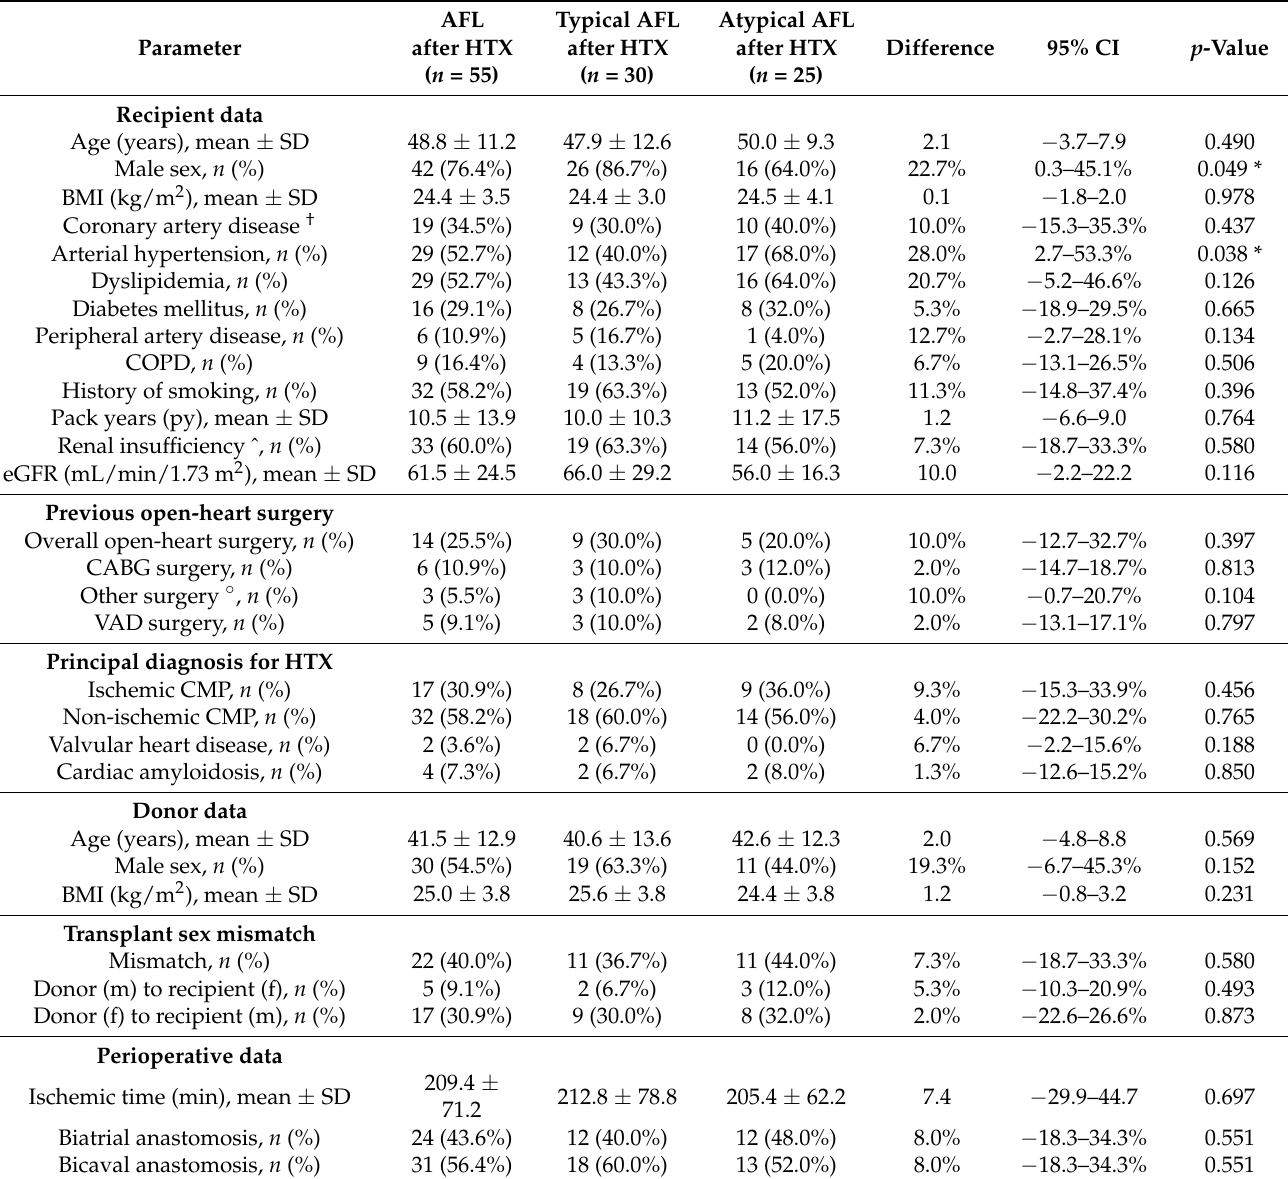
Table 2. Demographics-stratified by typical and atypical late-onset AFL after